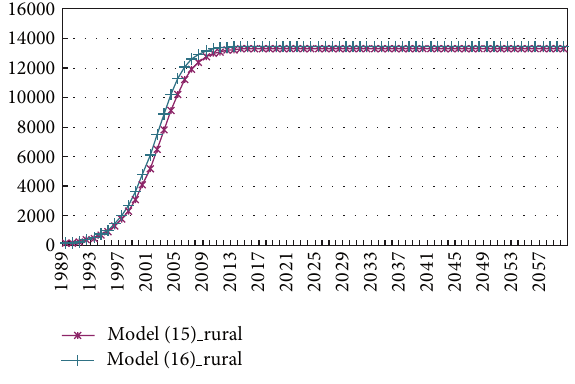
Figure 15: Plots of potential curve of telephone in rural area governed by model (69) or model